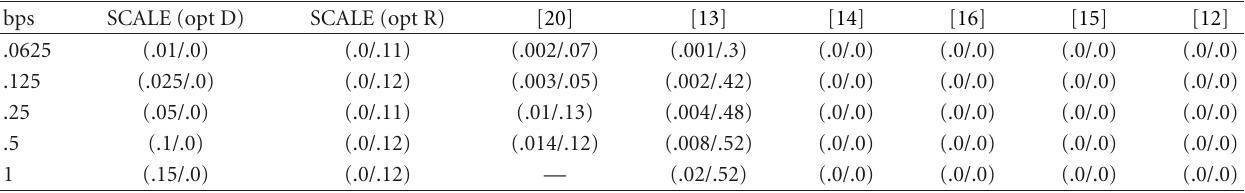
Table 3: Evaluation of the rate control and coding performance accuracy achieved by SCALE (corpus ISO 12640-1) and state-of-the-art methods (as claimed in the literature). Results are reported as ( r/d ) with r denoting the error between the target bitrate and the achieved one (in bps), and d denoting the error between the optimal coding performance achieved by PCRD and the evaluated method (in